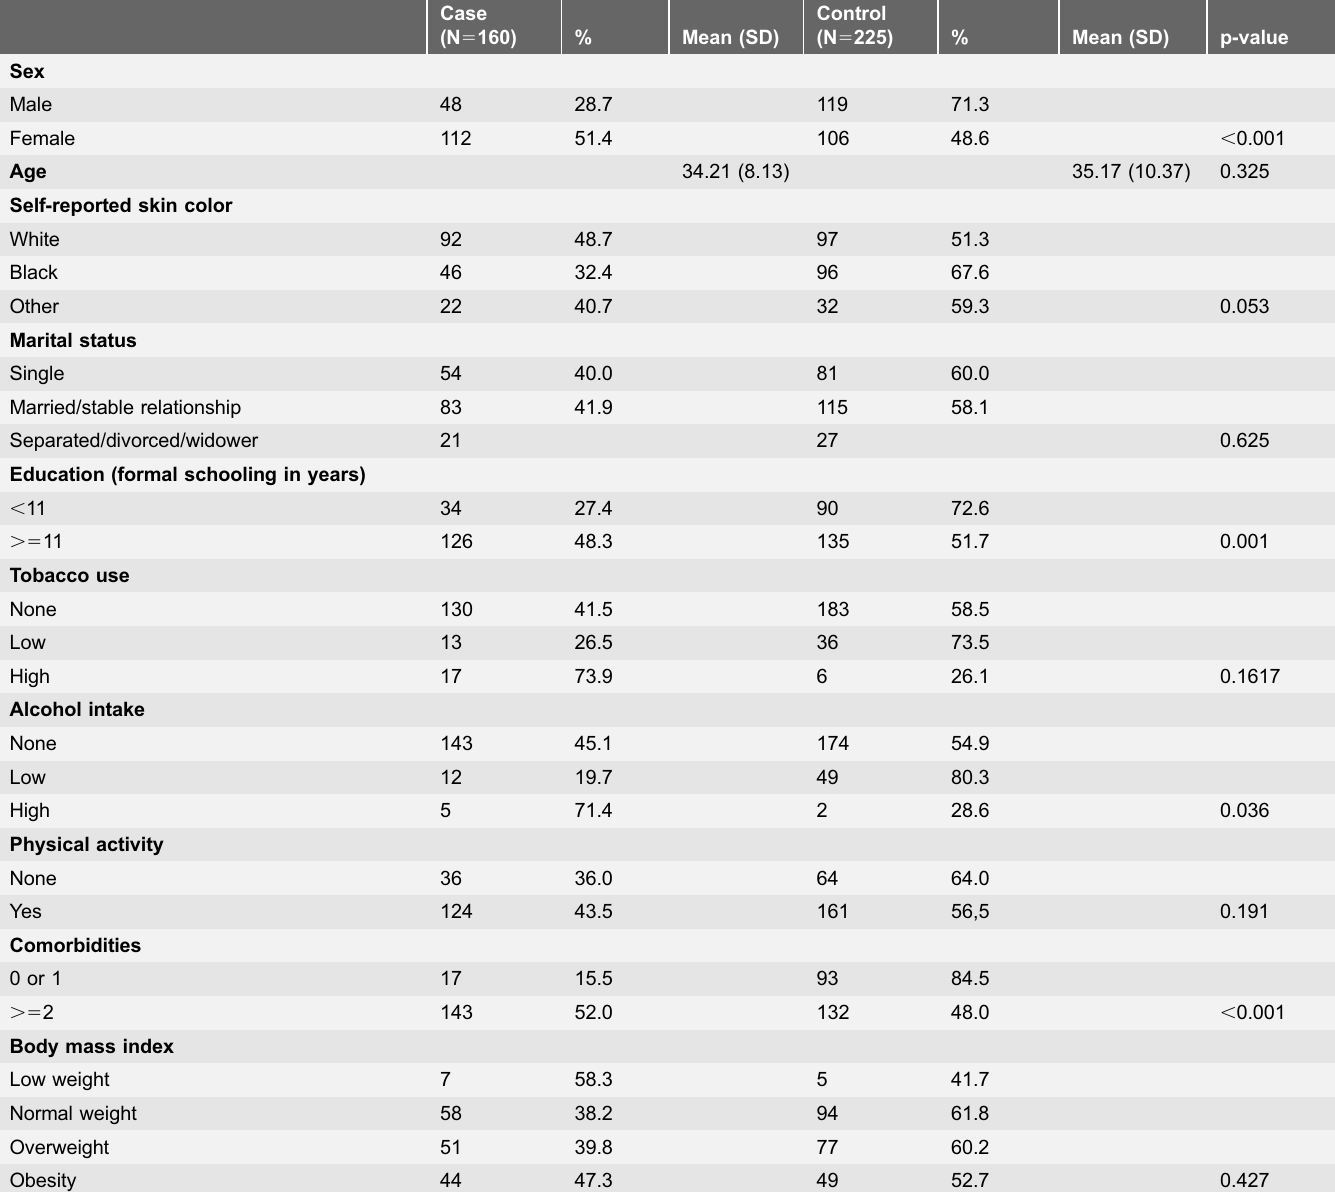
Table 1. Distribution of participants according individual features, Sa˜o Paulo, Brazil, 2011 (N 5